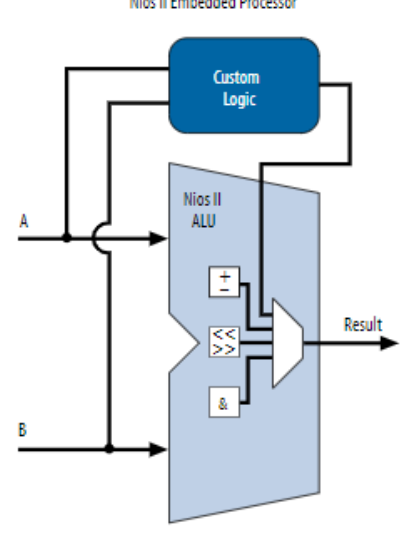
Figure 3. Nios II embedded processor with custom logic unit [22].